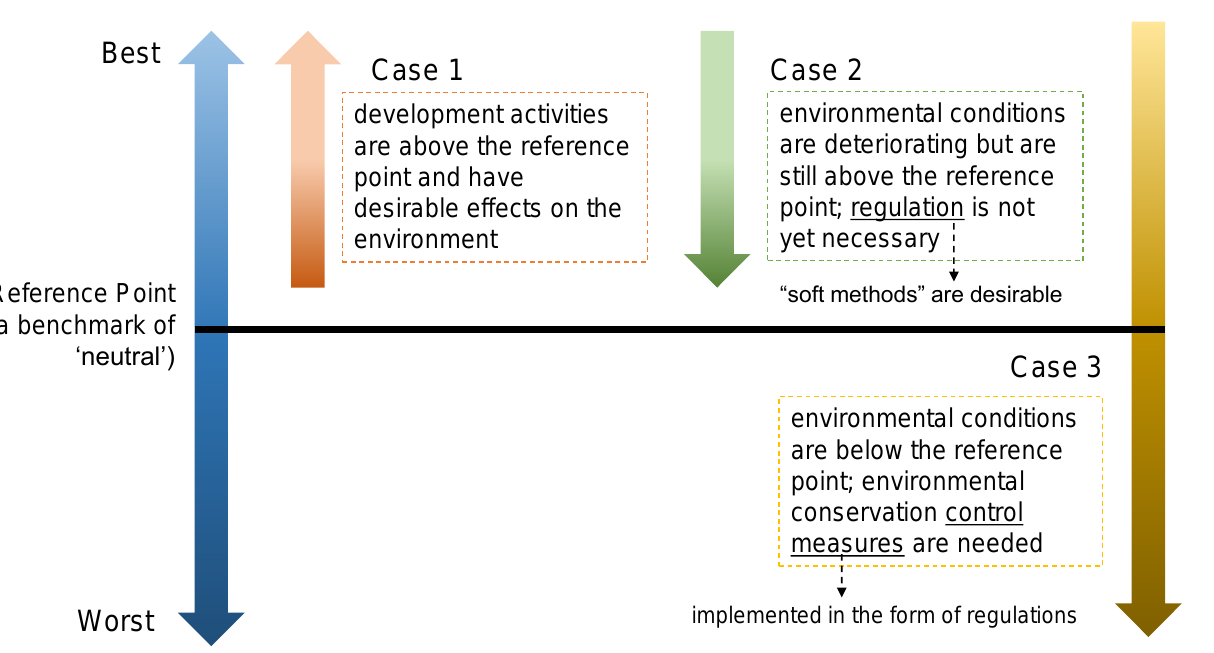
Figure 3. Conceptual framework of implementing Japanese regulations for environmental degrada- tion control measures (conceptualized from MoE